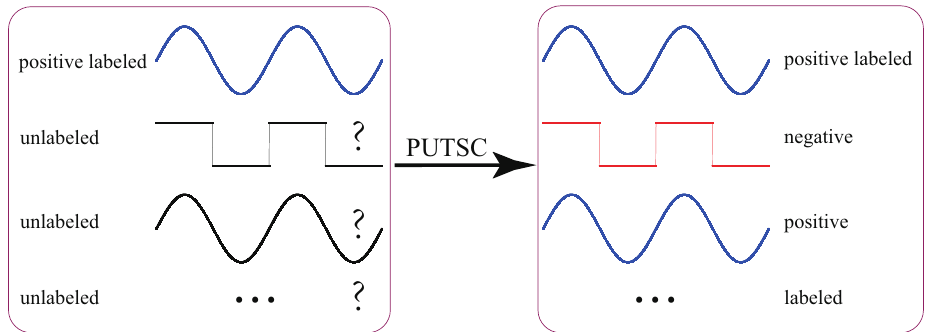
Figure 1. A simple example of PUTSC . Here we assume that the size of the PL set | PL | = 1. The task of PUTSC is to automatically label the large set of unlabeled time-series U based on PL